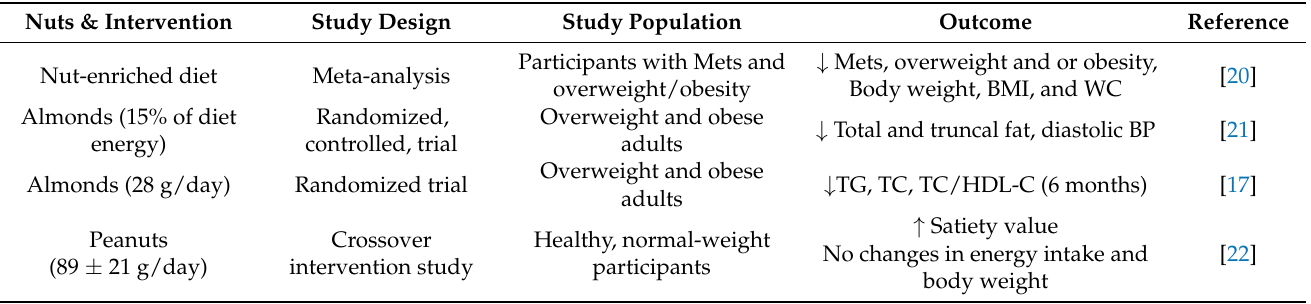
Table 2. Body weight management effects related to nut